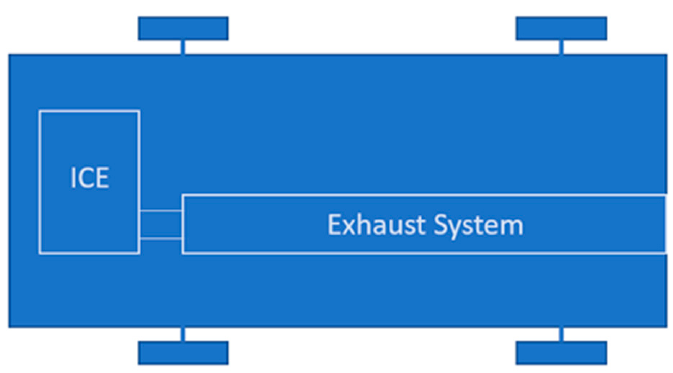
Figure 9. Layout of an electric drivetrain of an EV. Redrawn from [89]. In comparison, for diesel and petrol vehicles, the ICE is located within the engine bay, where the electric motor is situated in an EV, and the exhaust system runs from the bay, along the bottom of the chassis, to the back of the vehicle, as shown in Figure 10. Therefore, to retrofit a current ICE model, the components have to be removed and the available space has to be utilised as appropriately as possible, to fit the electric drivetrain. This will likely require additional mounts and brackets to be added, to hold parts in place, due to the original vehicle design, not considering these new components. Effectively, the electric drivetrain system shown above in Figure 9 must fit into the ICE vehicle layout, shown below in Figure 10. For newer vehicles this may appear simple as the ICE model and EV model may be very similar, despite their fuel type, however completing this process for old classic vehicles that do not have a new electric version already being manufactured, requires new designs and solutions to be created.